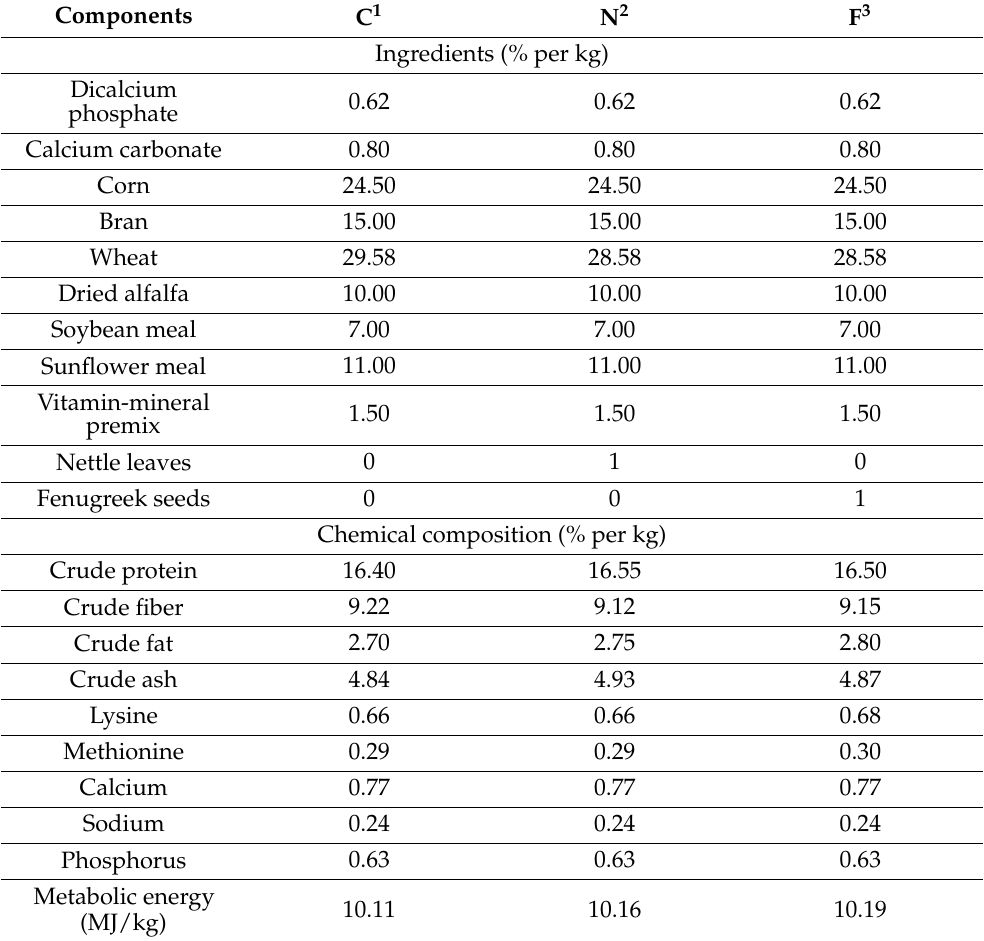
Table 1. Ingredients and chemical composition of the control and experimental feed (according to feed manufacturer FHP Barbara Ltd.).